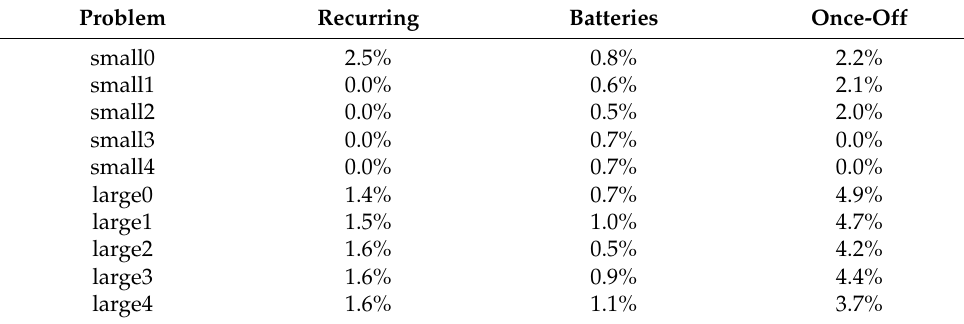
Table 6. Percentage optimality gaps of sub-optimization on all ten problem instances.